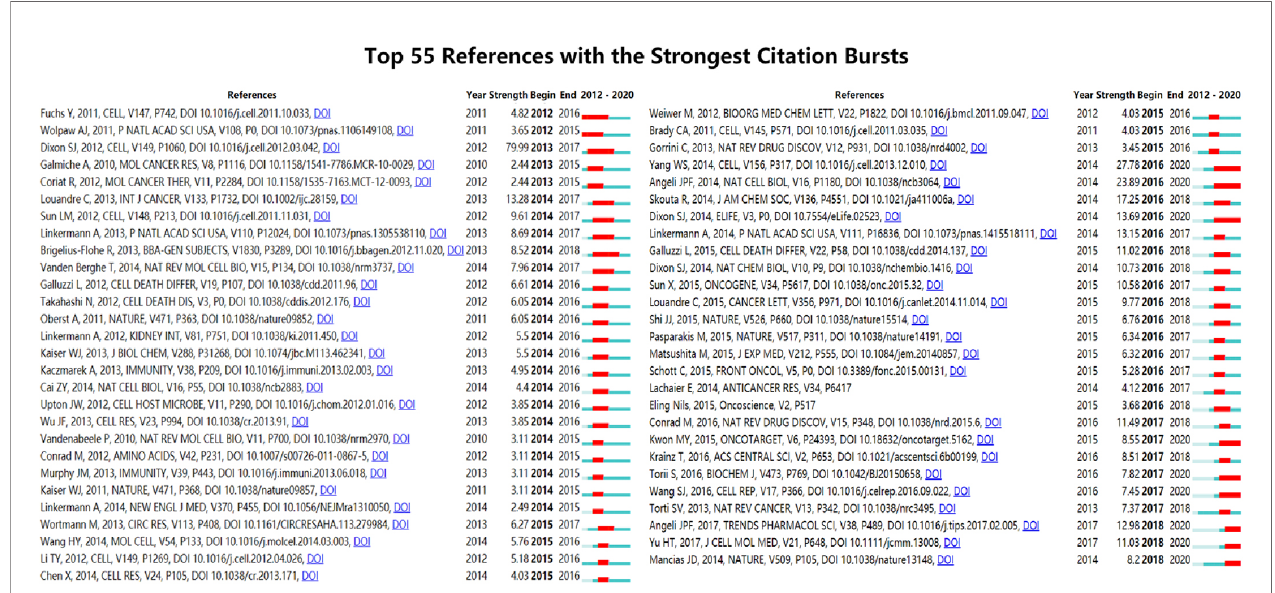
FIGURE 9 | Top 55 references with the strongest citation bursts (sorted by the beginning year of burst). Notes: The Blue bars mean the reference had been published; the red bars mean citation